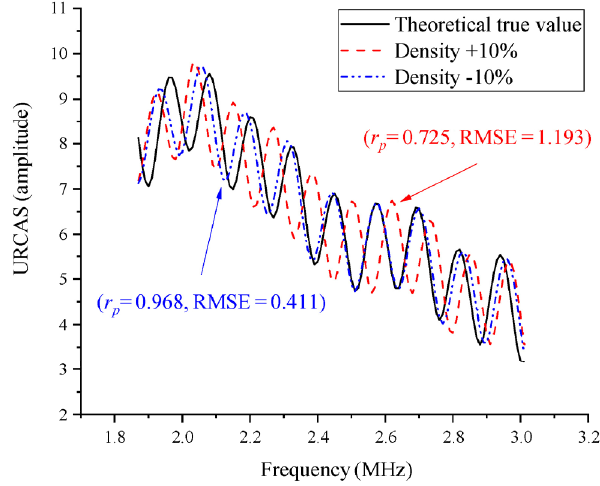
Fig. 6 Effect of density fluctuation ± 10% on URCAS.